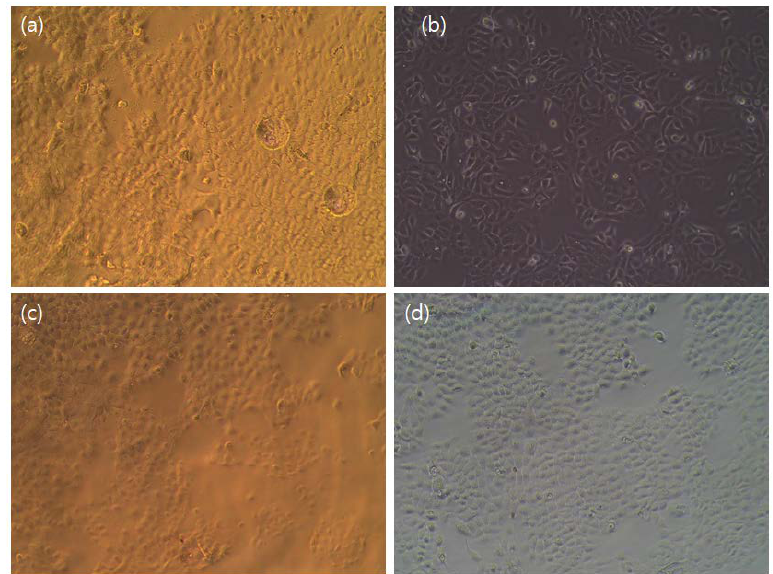
Figure 10. Light microscopy images of HaCaT cell line for composites having: ( a ) only CP, ( b ) 1:0.5 CP/PU, ( c ) 1:1 CP/PU, and ( d ) 1:1 CP/PU with 10 wt% curcumin.